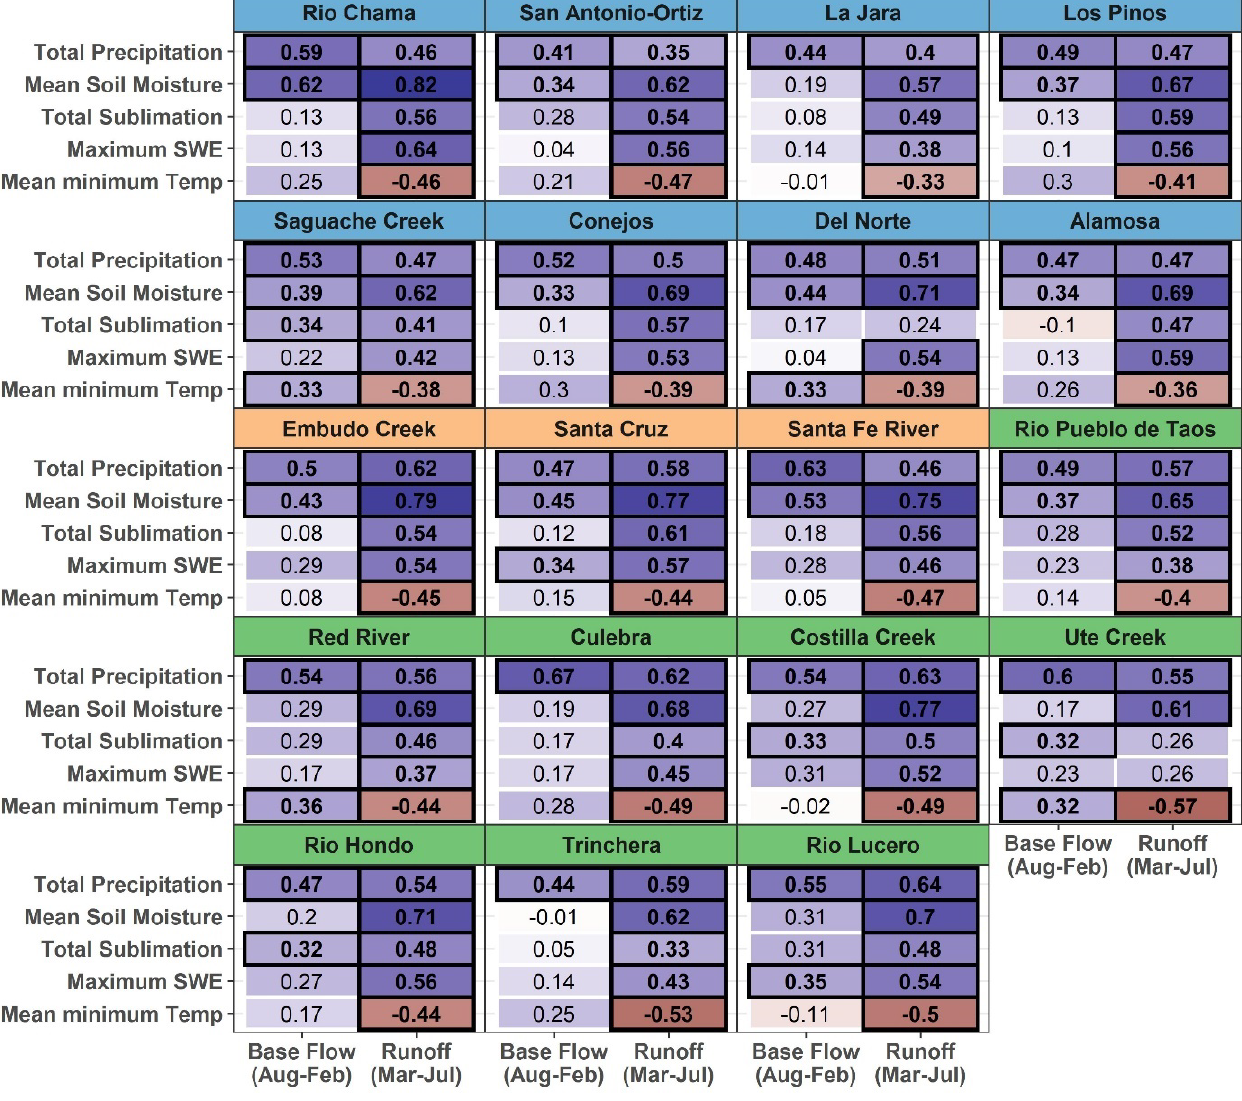
Figure 9. Pearson’s correlation coefficients with naturalized streamflow for subbasins of the Upper Rio Grande. Outline indicates significance at p = 0.05, color indicates positive or negative correlation, and shade corresponds with x.